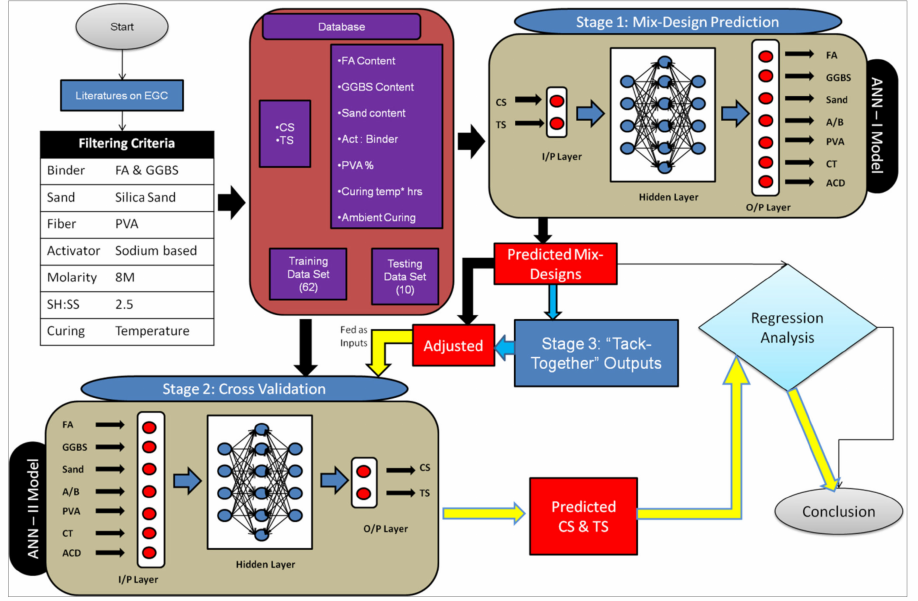
Figure 1. Methodology of